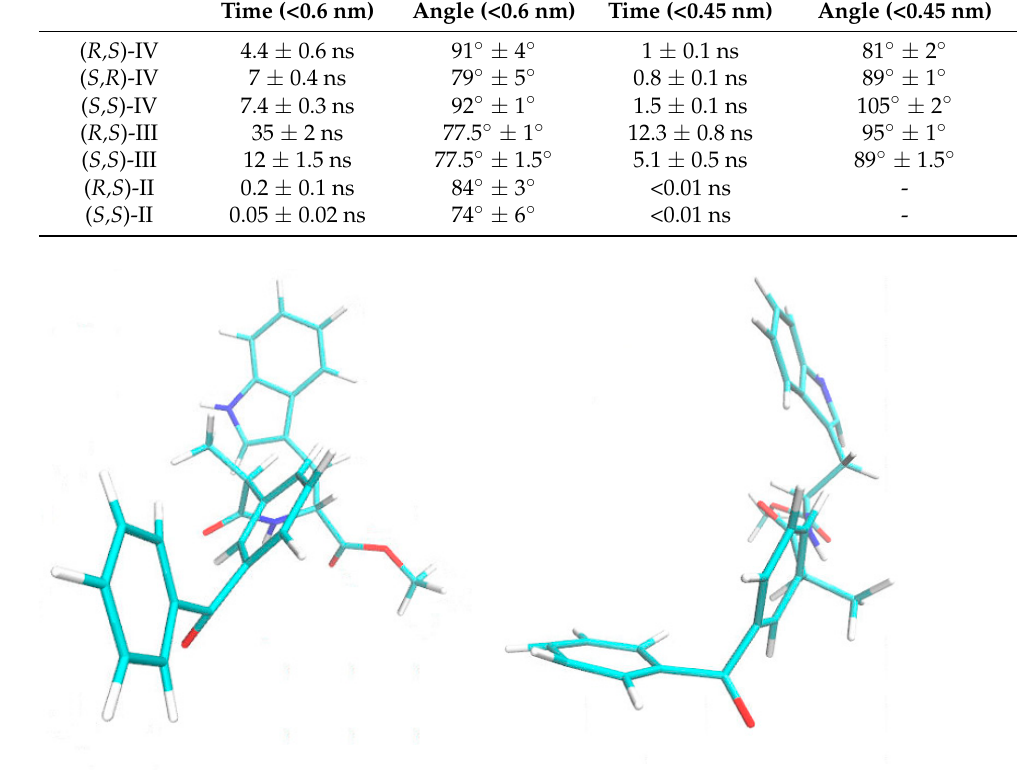
Figure 5. Example of dimer structures for ( R,S )-IV. The spheres mark the atoms, the distance be- tween which was taken for analysis. Figure 6. Dimer configurations for the ( S,S )-III. The case of the closest arrangement of a naproxen fragment with a tryptophan ( left ) and two naproxen residues ( right ). The spheres mark the atoms, the distance between which was taken for analysis.